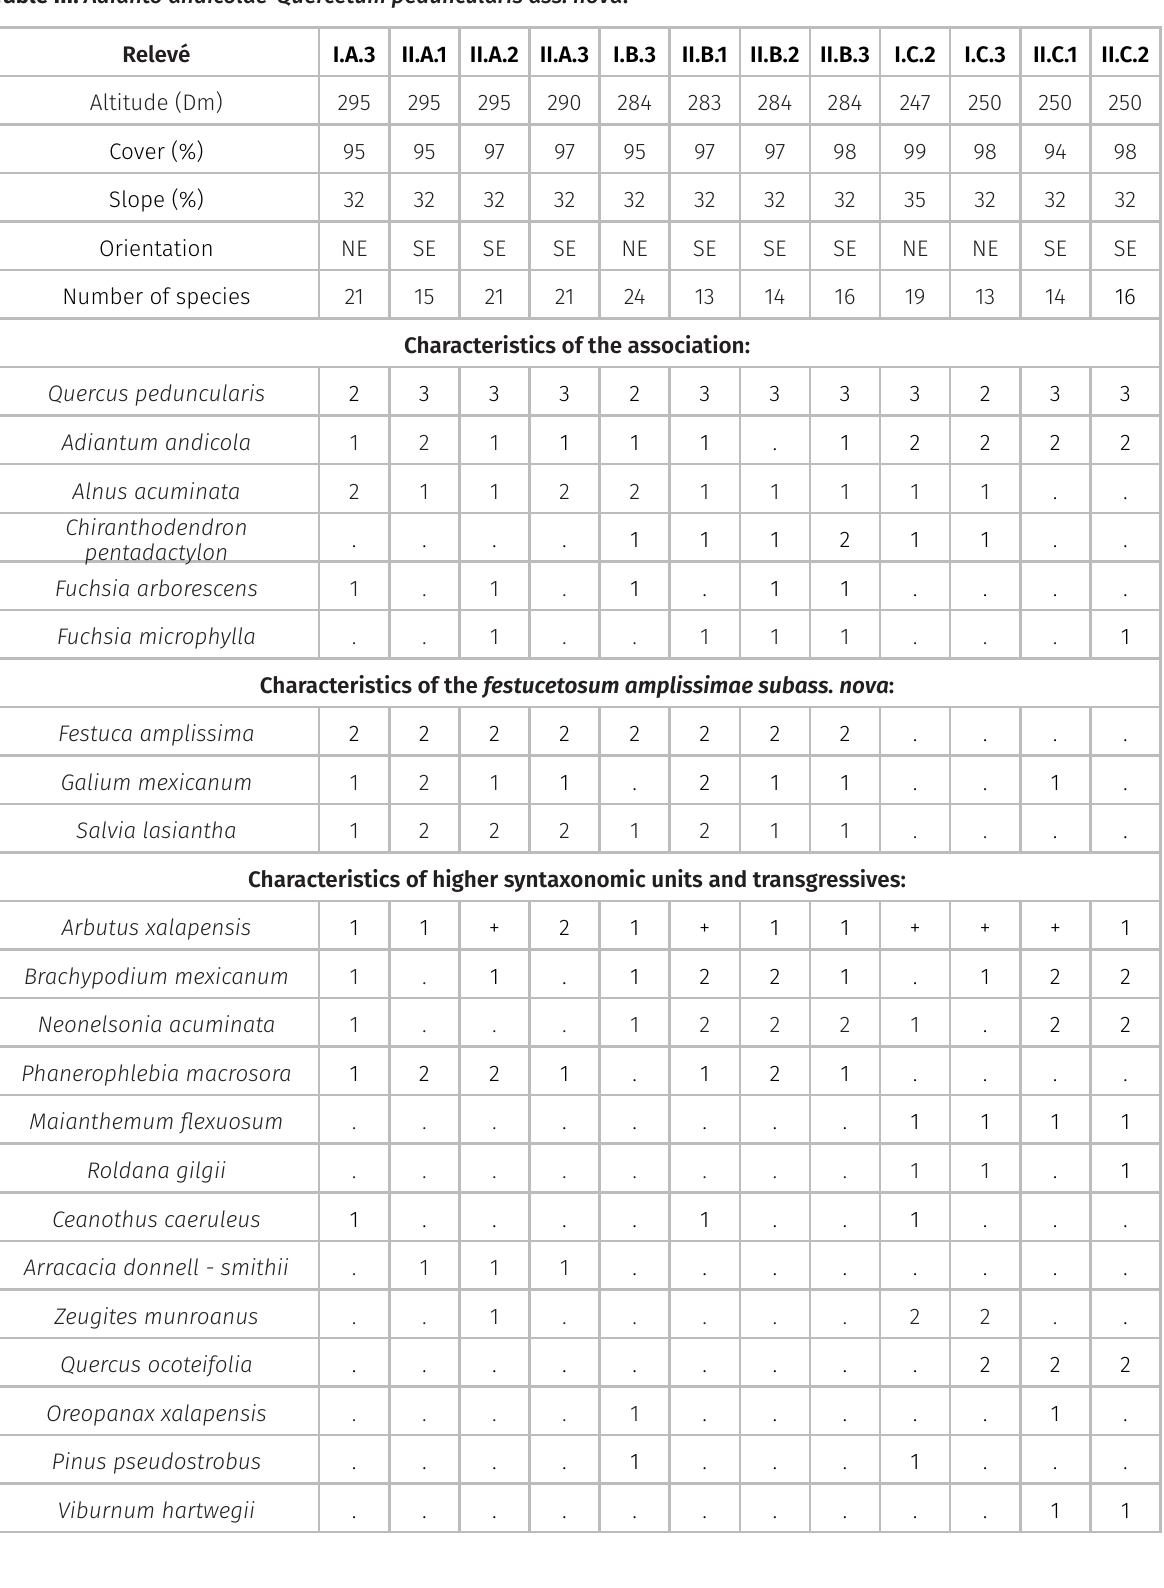
Table III. Adianto andicolae-Quercetum peduncularis ass. nova . Relevé